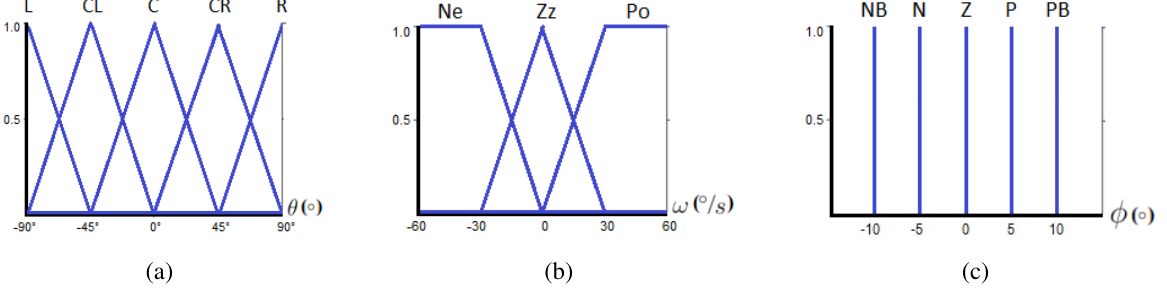
Figure 6. Fuzzy subsets for inputs and output. ( a ) θ subsets. ( b ) ω subsets. ( c ) φ